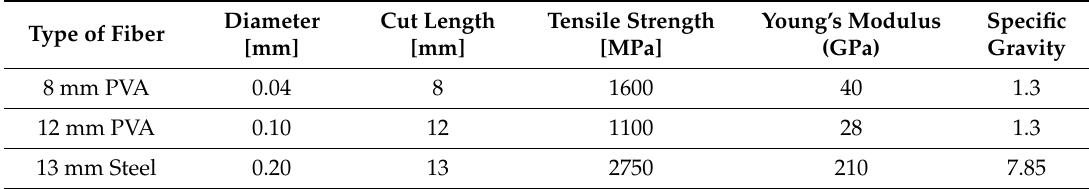
Table 2. Technical information about Poly-Vinyl-Alcohol (PVA) and steel fibers